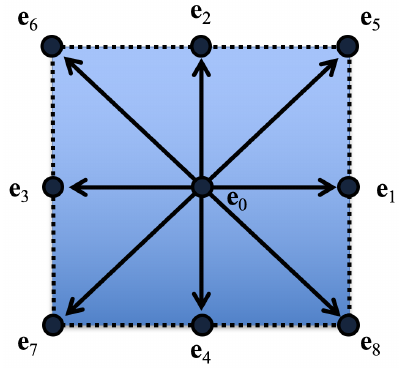
Figure A1. Figure illustrating the possible streaming directions, { e i } for the D2Q9 Lattice Boltzmann